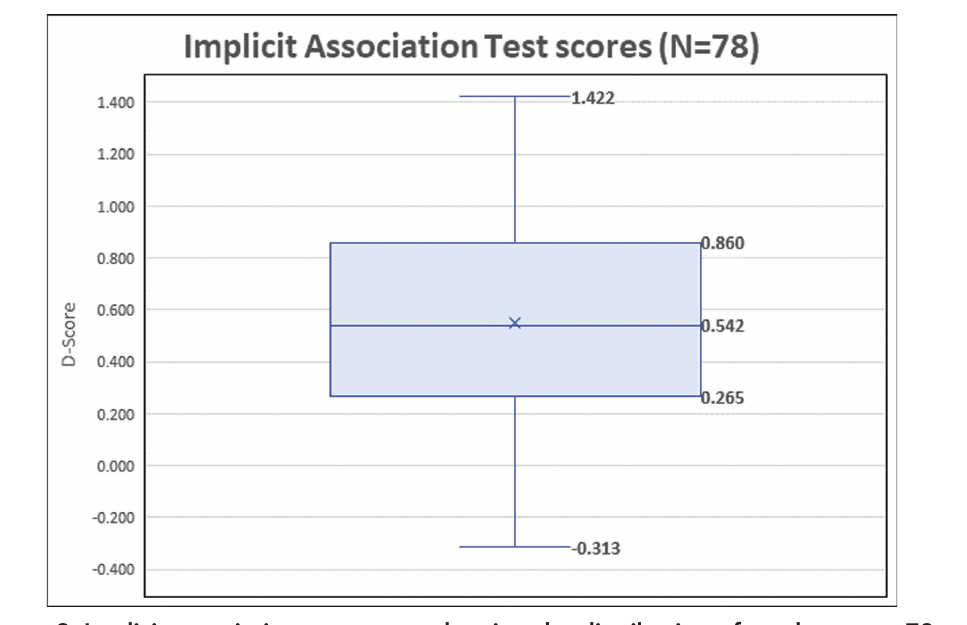
2: Implicit association test scores showing the distribution of results across 78 faculty respondents. D-scores represent the associations between the categories ‘high- income country/low-income country’ and ‘good research/bad research’. A D-score of 0 represents no implicit association between categories (Source: Authors,